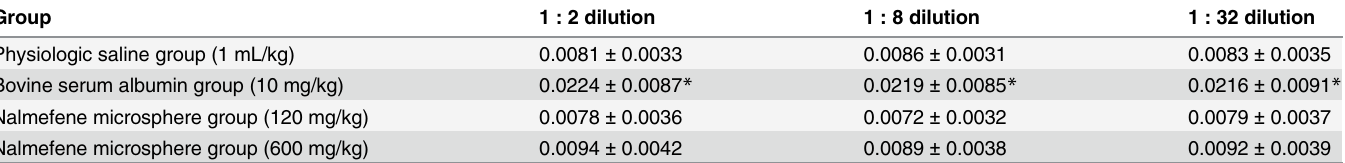
Table 2. Optical density (OD) values at day 1 after the passive cutaneous anaphylaxis test in rats (n = 4). Group